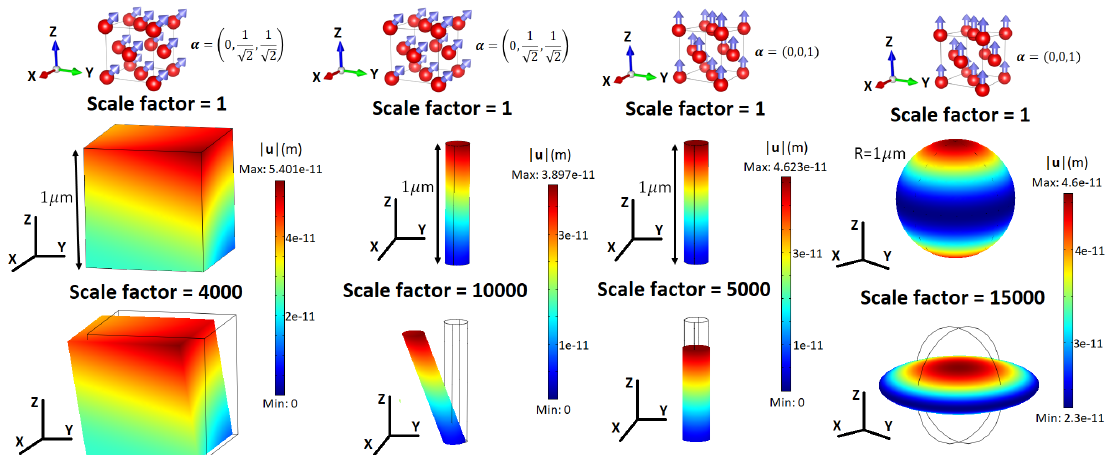
Figure 2. Deformation of single-crystal face-centered cubic (FCC) Ni due to the Joule effect for three material geometries: cube, cylinder, and sphere. The saturated magnetization points to direction √ √ α = ( 0,1/ 2,1/ 2 ) for the cube and cylinder on the left, while it points to α = ( 0,0,1 ) for the cylinder and sphere on the right. The color of the surface gives the magnitude of the displacement vector u